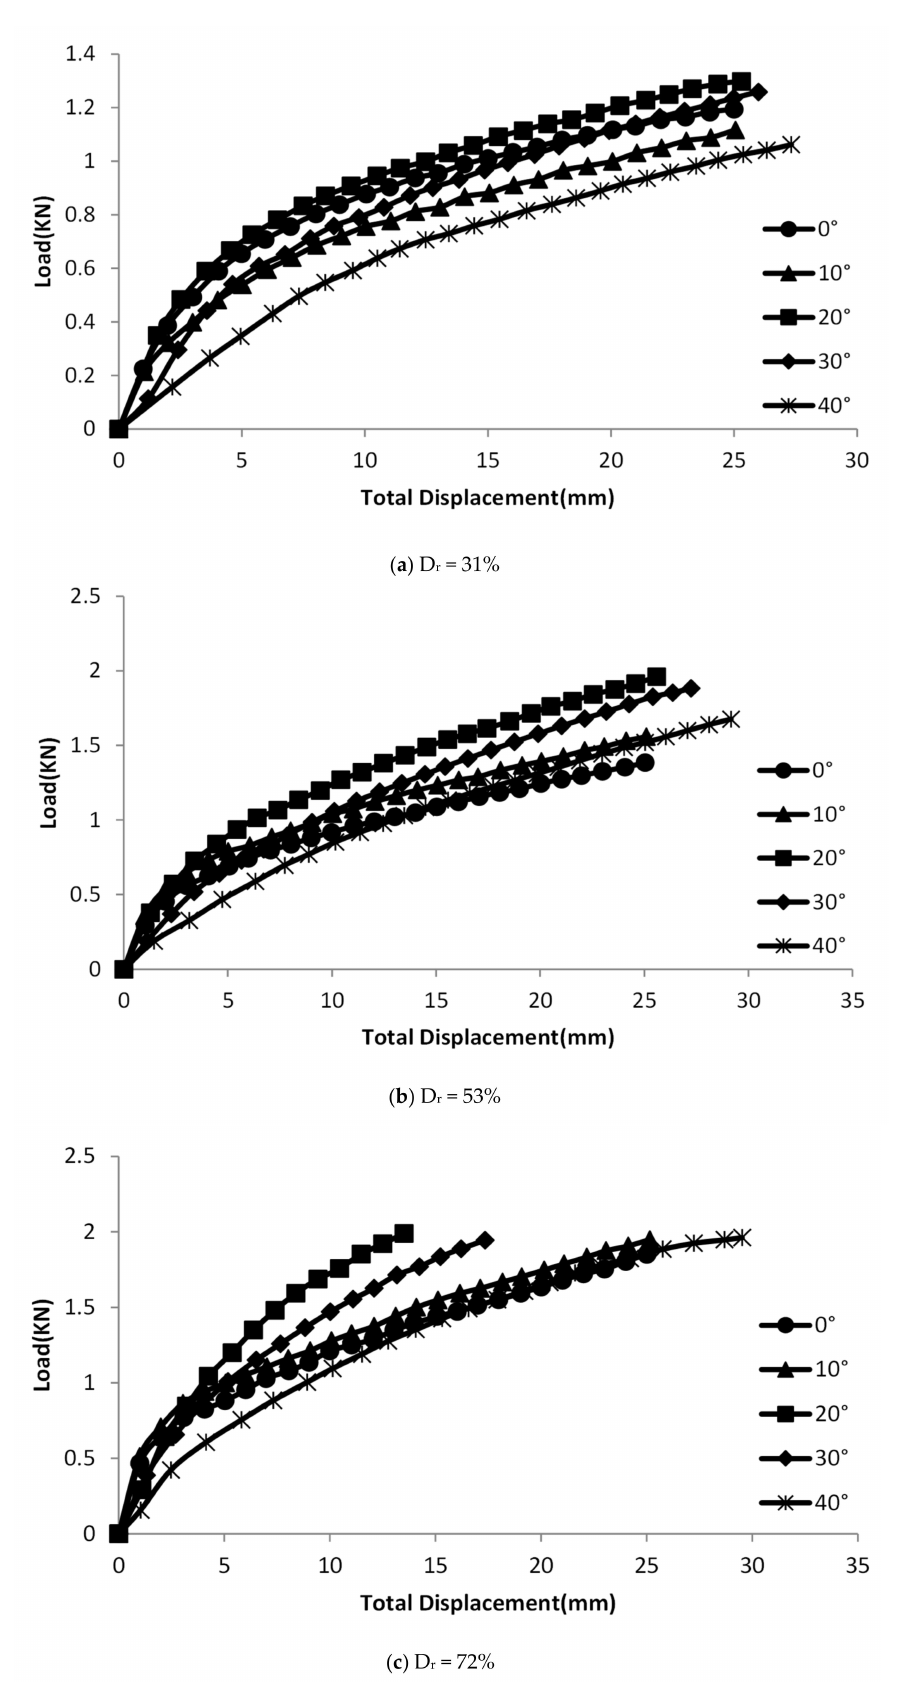
Figure 10. Relation of vertical load and pile head total